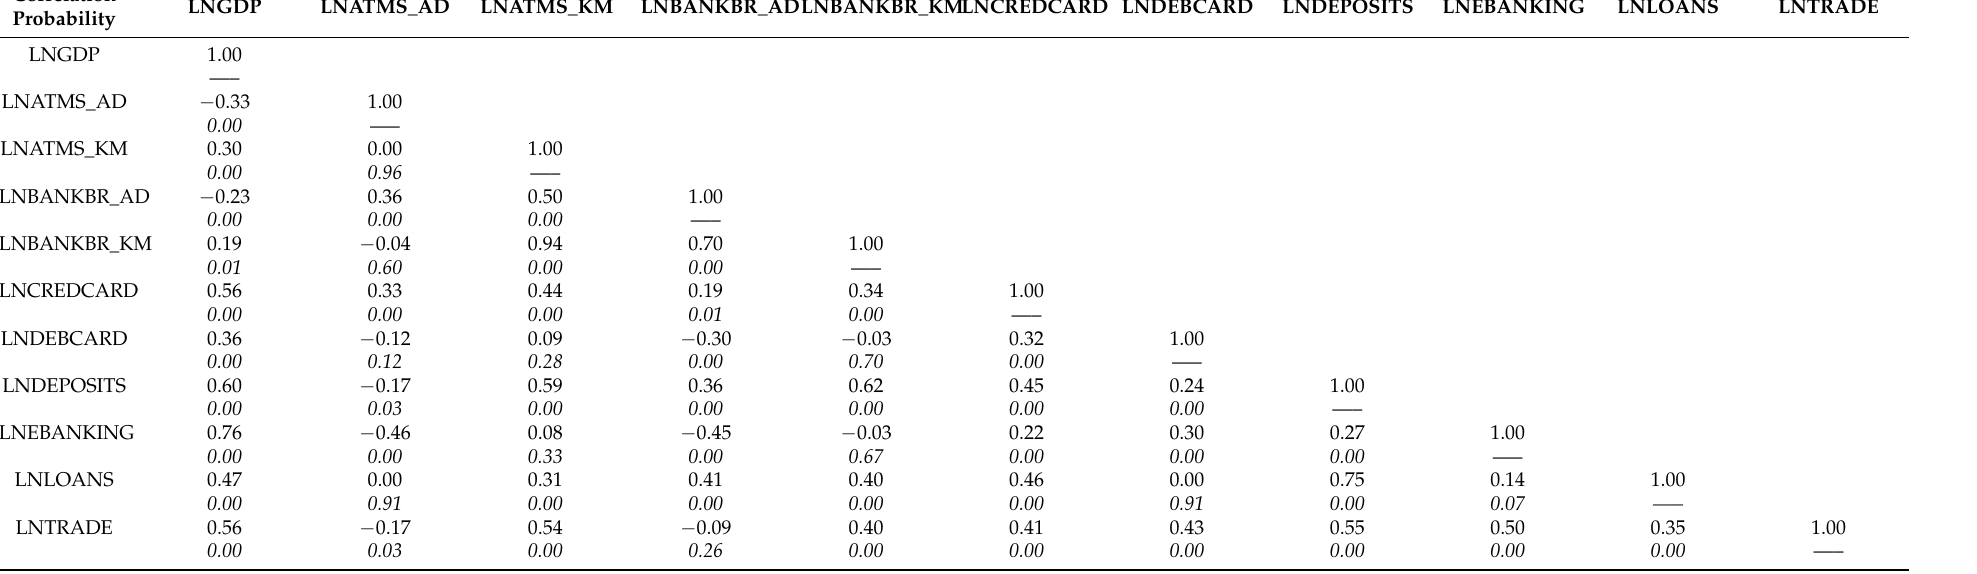
Table 2. Correlation